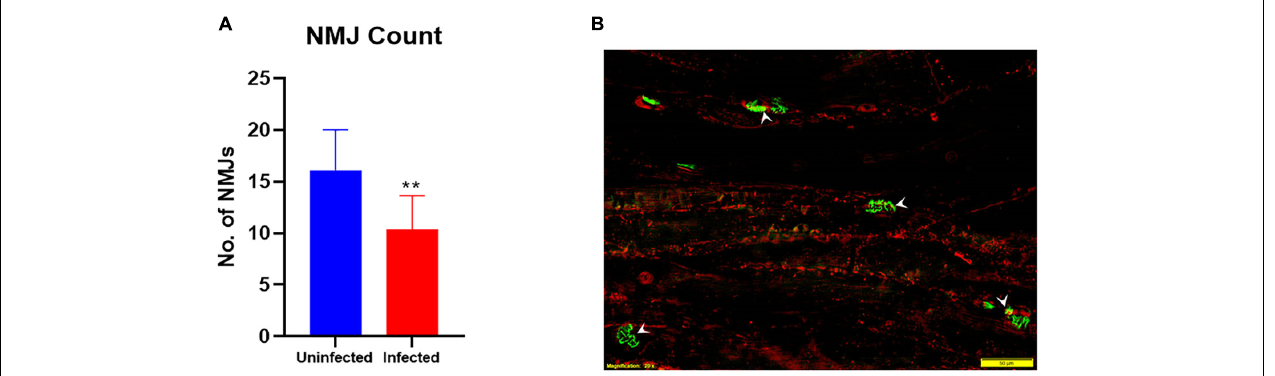
FIGURE 7 | M. leprae infection causes degeneration of neuromuscular junctions (NMJ’s) in the armadillo footpad muscles. The number of NMJs (A) is reduced (** p = 0.0012) in M. leprae -infected armadillos (terminal stage) as measured in 30 µ m-thick, 30 2 mm muscle sections. Fluorescent micrograph (B) of footpad intrinsic muscle in an M. leprae -infected armadillo showing NMJs (green, arrowheads) stained with FITC- α -bungarotoxin and muscle fibers (red) stained with PE-anti-myosin. ( N = 8).